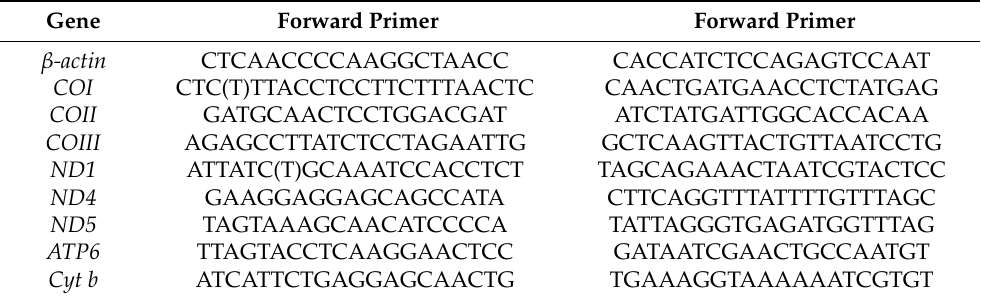
Table 3. Primer sequences of eight mitochondrial protein-coding genes and β -actin gene designed for RT-qPCR experiment in this